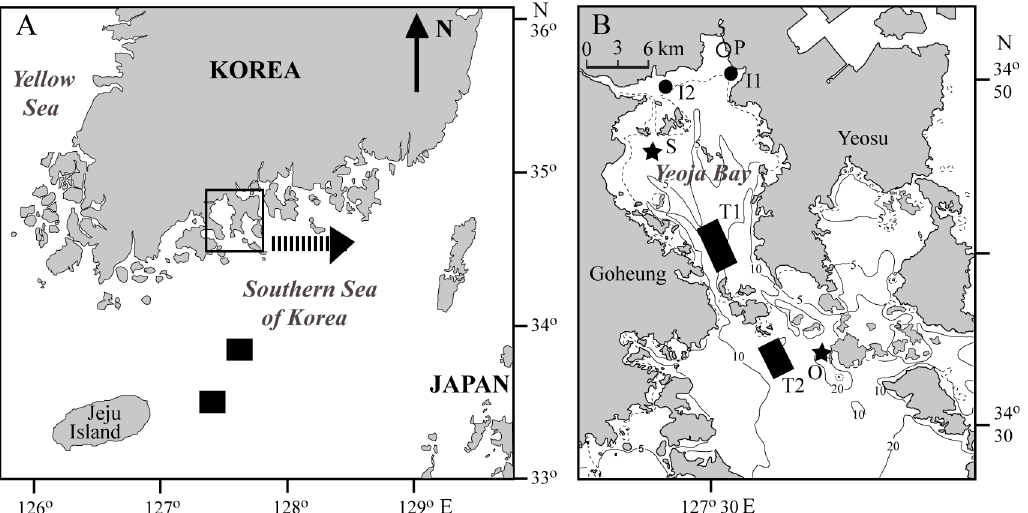
Fig 1. (A) Schematic map of the Southern Sea of Korea with offshore sampling locations and (B) two intertidal and two subtidal sampling sites in the Yeoja Bay. Black squares (A) and rectangles (B) represent offshore and subtidal (T1 and T2) trawling sites, respectively; black circles (B) indicate intertidal sites (I1 and I2) where fence nets were deployed. The common reed Phragmites australis was collected at Site P. The ark shell Scapharca subcrenata and the Pacific oyster Crassostrea gigas were cultured by local fishermen and collected at sites S and O,